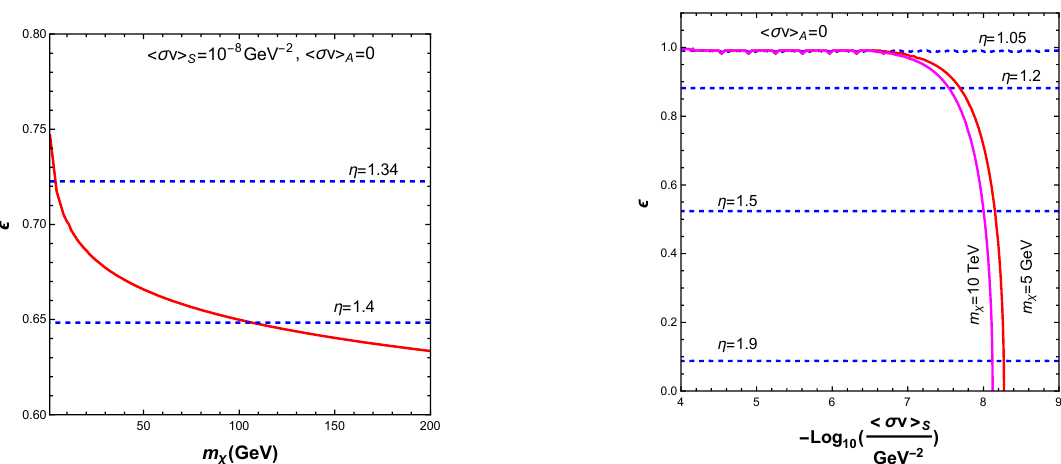
Figure 3 . Contour in the m (cid:31) (cid:15) plane (left panel, red solid line) in which the central value of the (cid:0) DM relic density (cid:10) h 2 = 0 : 12 is reproduced, for a (cid:12)xed value of the semi-annihilation rate. Same (cid:27)v (cid:15) plane for two di(cid:11)erent values of m (cid:31) (right panel, red and pink solid lines). contours in the h i S (cid:0) Also shown in both panels are contours of constant values of the relative abundance of DM and anti- DM, parametrized as (cid:17) = ( Y (cid:31) ( ) + Y (cid:31) y ( )) =Y (cid:31) y ( ), with (cid:17) 1 being completely asymmetric 1 1 1 ! DM. Only the semi-annihilation process has a non-zero rate in both the (cid:12)gures. See text for details. (cid:15) plane (red solid line) in which In (cid:12)gure 3 (left), we show the contour in the m (cid:31) (cid:0) the central value of the DM relic density (cid:10) h 2 = 0 : 12 is reproduced. For this (cid:12)gure, we